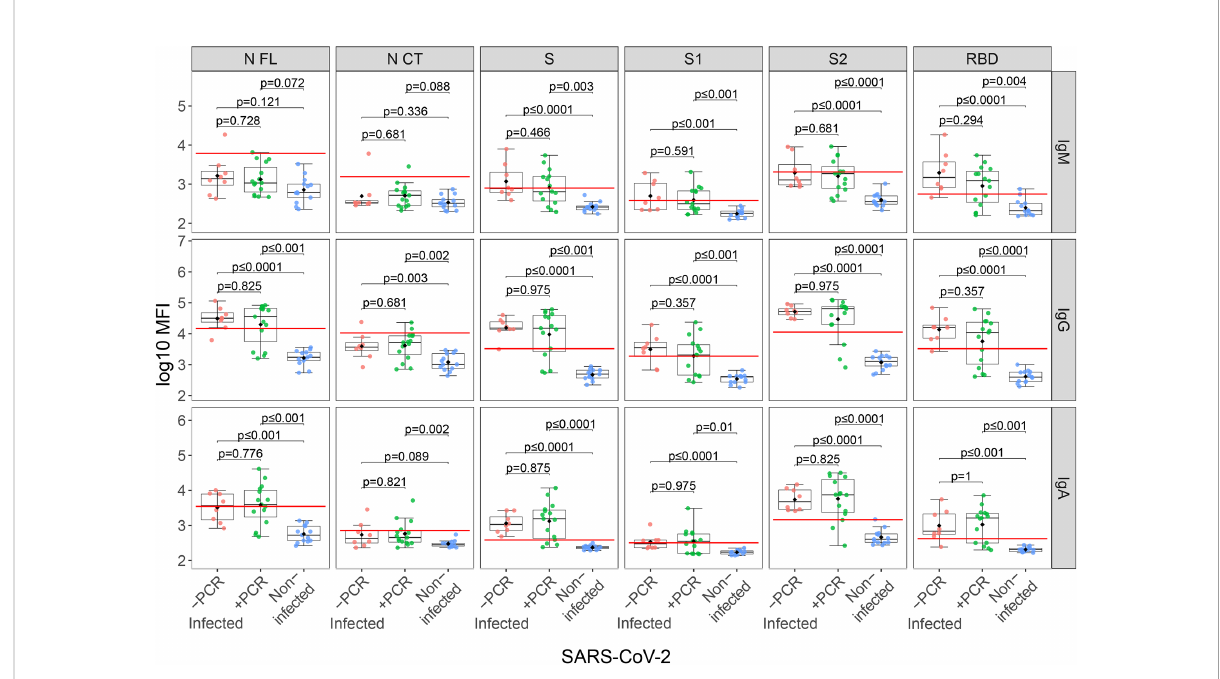
FIGURE 1 Anti-SARS-CoV-2 antibody levels in mothers strati fi ed by infection and rRT-PCR (PCR) results. Comparison of anti-SARS-CoV-2 IgM, IgG and IgA serum levels (log 10 median fl uorescence intensity, MFI) between infected mothers who tested COVID-19 positive by rRT-PCR during the third trimester (+PCR, N=15, in green), those that tested negative (-PCR, N=8, in red) and non-infected mothers (N=13, in blue). The boxplots represent the median (bold line), the mean (black diamond), the 1 st and 3 rd quartiles (box) and the largest and smallest values within 1.5 times the inter-quartile range (whiskers). Groups were compared by the Wilcoxon-rank-sum-test. The red line indicates the seropositivity cutoff calculated as 10 to the mean plus 3 standard deviations (SD) of log 10 -transformed MFI of 129 pre-pandemic controls. Antigens: nucleocapsid full-length (N FL) and C-terminus (N CT), spike full-length (S), S1 and S2 subunits, and receptor-binding domain